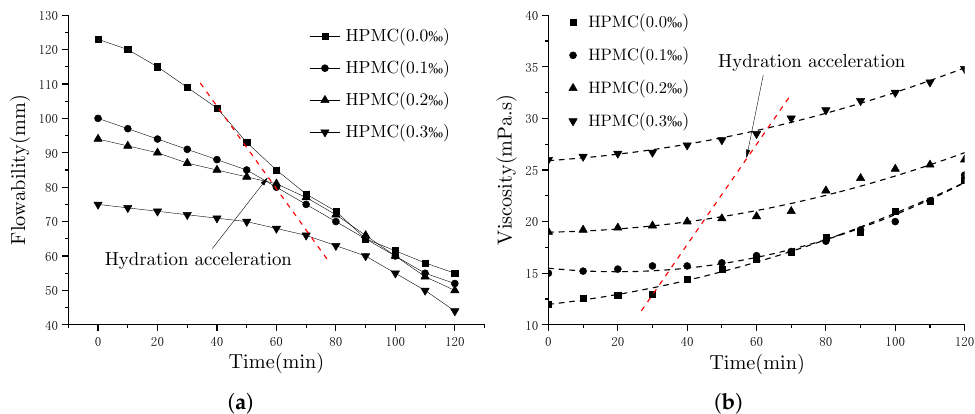
Figure 3. Flow properties of the fresh cement mortars at a w/c ratio of 0.4. ( a ) Flowability curves of fresh cement; ( b ) viscosity curves of fresh